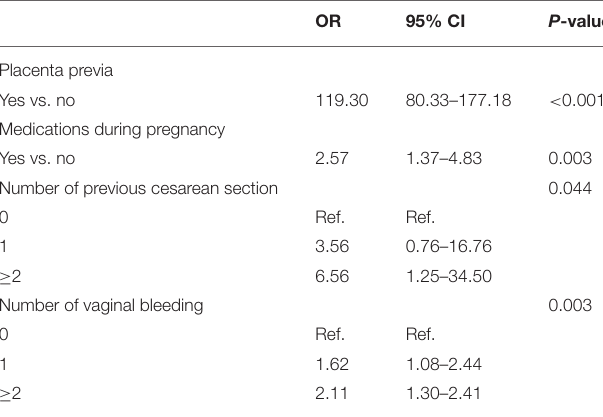
TABLE 3 | Multivariable logistic regression analyses between the placenta accreta group and the non-placenta accreta group in the training set ( N = 5,581). OR 95% CI P -value